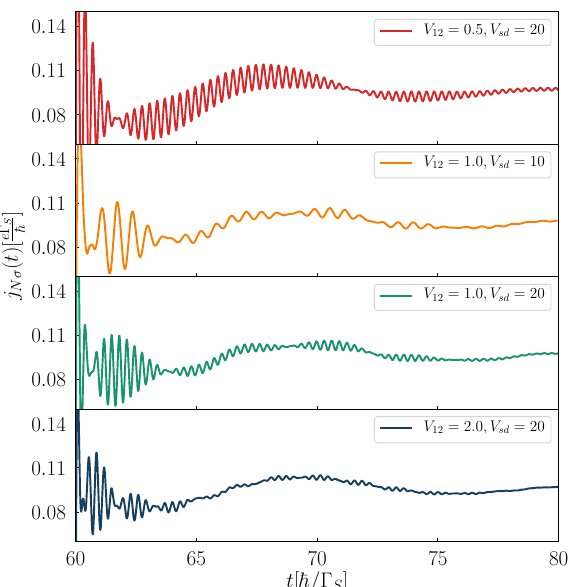
Figure 3. Post-quench beating patterns. The Andreev current j N σ ( t ) induced by abrupt biasing at t several values of the interdot coupling V 12 and V sd (in units of Ŵ S ), as indicated. We used the model parameters 0 , Ŵ 0 , ε 0.2 . U i σ = N /Ŵ S = =